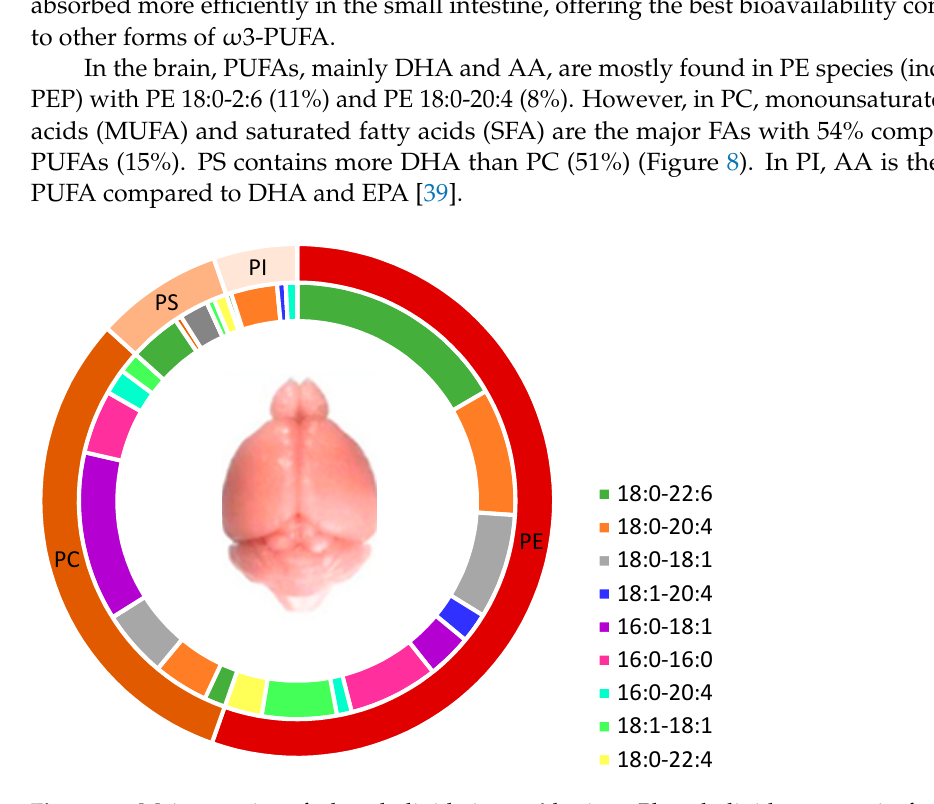
Table 1. Concentration of different phospholipids in the brain, heart, kidney, and liver of rats